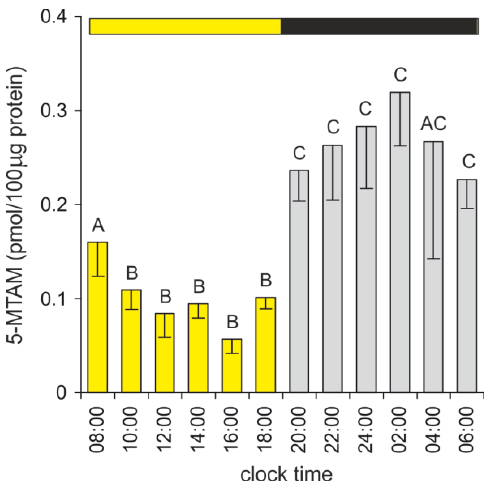
Figure 8. The content of 5-MTAM in the duck pineal organs taken at two-hour intervals over a daily cycle (means and standard errors, n = 5). For explanations, see Figure